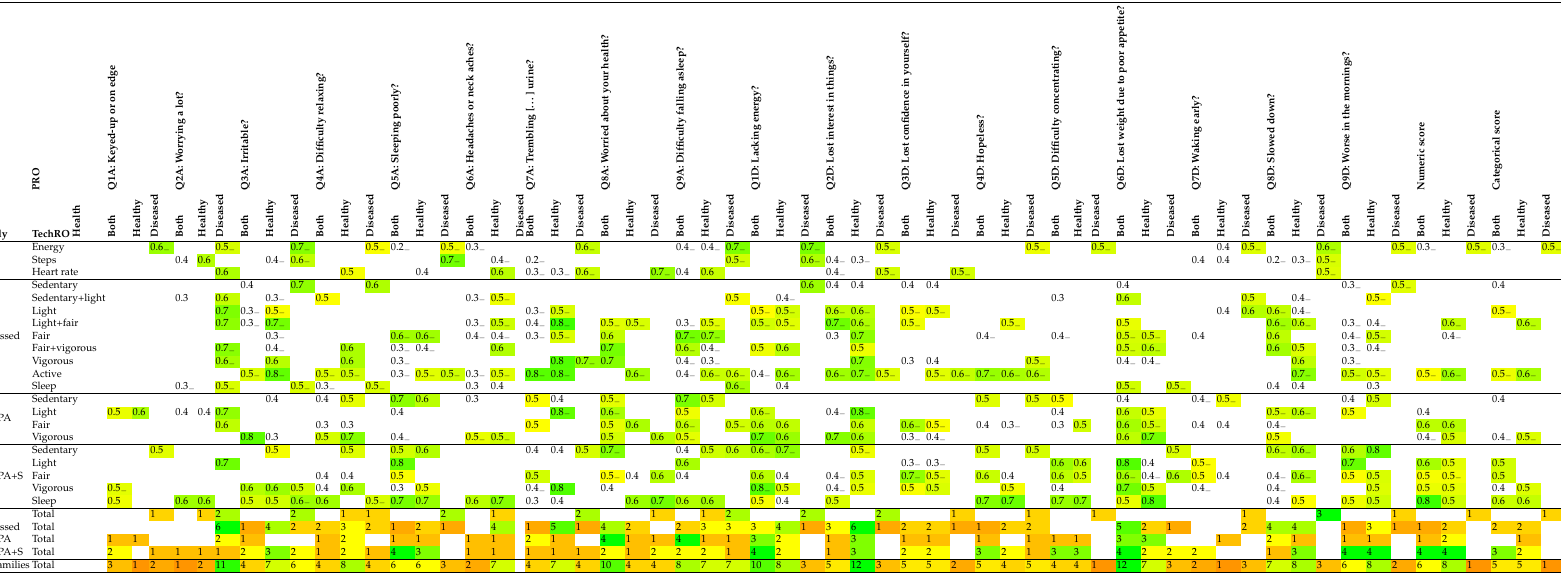
Table A15. Correlation coefficient (Spearman r S ) between TechROs from Fitbit (rows) and PROs of Depression and Anxiety on the GADS scale